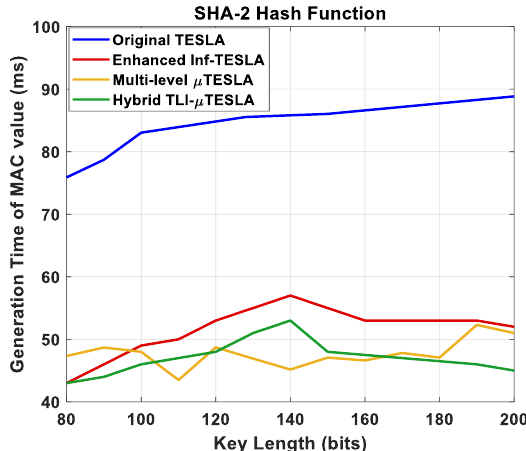
Figure 7. Simulation results of the original TESLA protocol (blue line), enhanced Inf-TESLA protocol (red line), Multilevel-µTESLA protocol (yellow line), and Proposed Hybrid TLI-µTESLA protocol (green line), demonstrating the computational overhead at the receiver side during the generation of the MAC value with the change in the key size to authenticate the received packet using SHA-2 hash function.